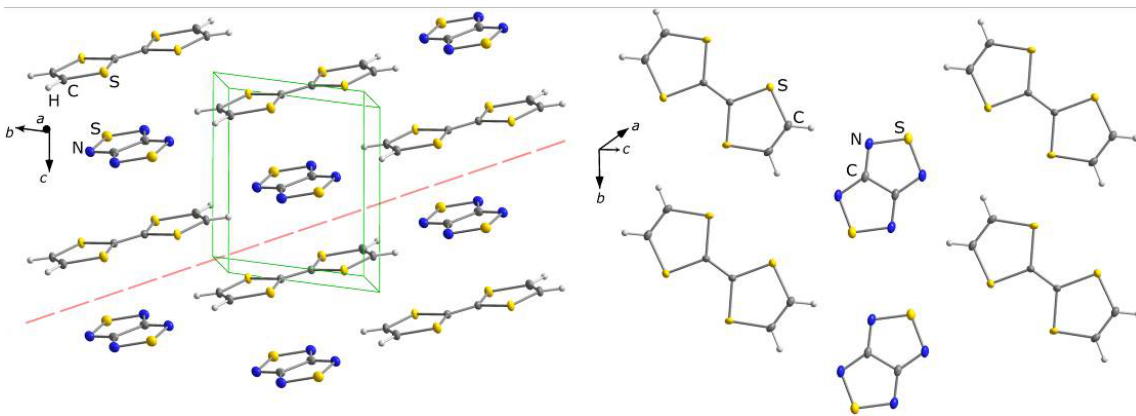
Figure 5. XRD structure of CT complex TTF ·22 . Layers containing flat D and A molecules are extended in the directions marked by the dashed line (left). Each layer contains the alternated rows of D and A molecules propagated along the b axis